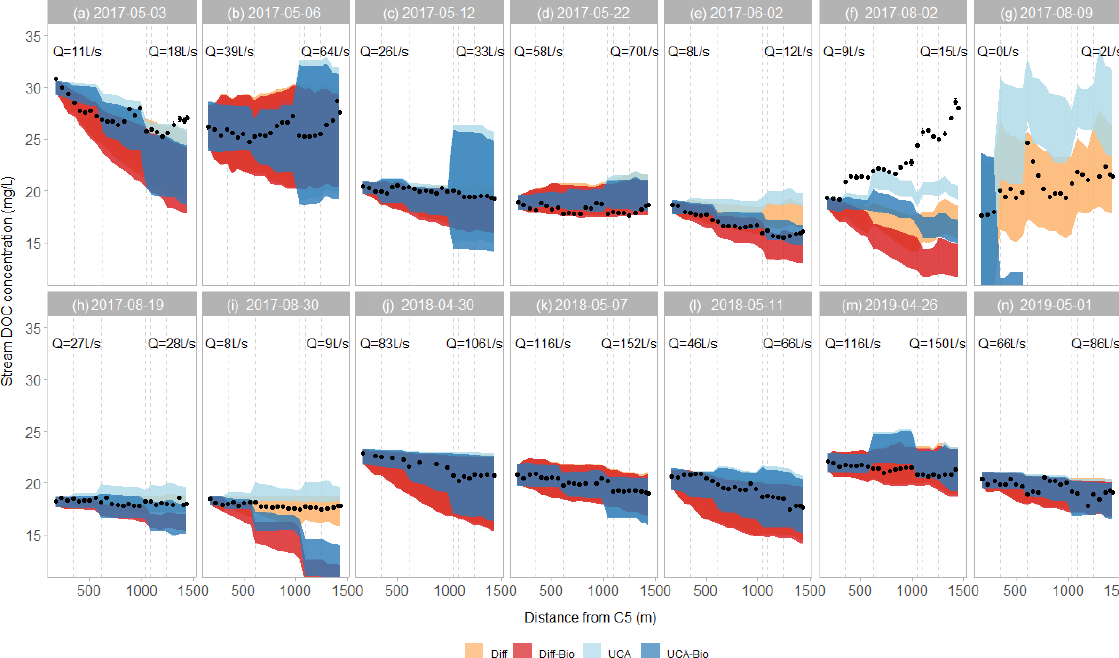
Figure 4. Longitudinal patterns of DOC concentrations along the C5–C6 reach. Each panel, indicated by label and date, shows one sampling campaign. The black dots are the observed stream DOC concentrations. The colored bands show the simulations of the four models. The vertical grey lines show the locations of DRIPs with wells (solid) and without wells (dashed). The streamflows ( Q ) at gauging stations C5 and C6 are shown for each sampling